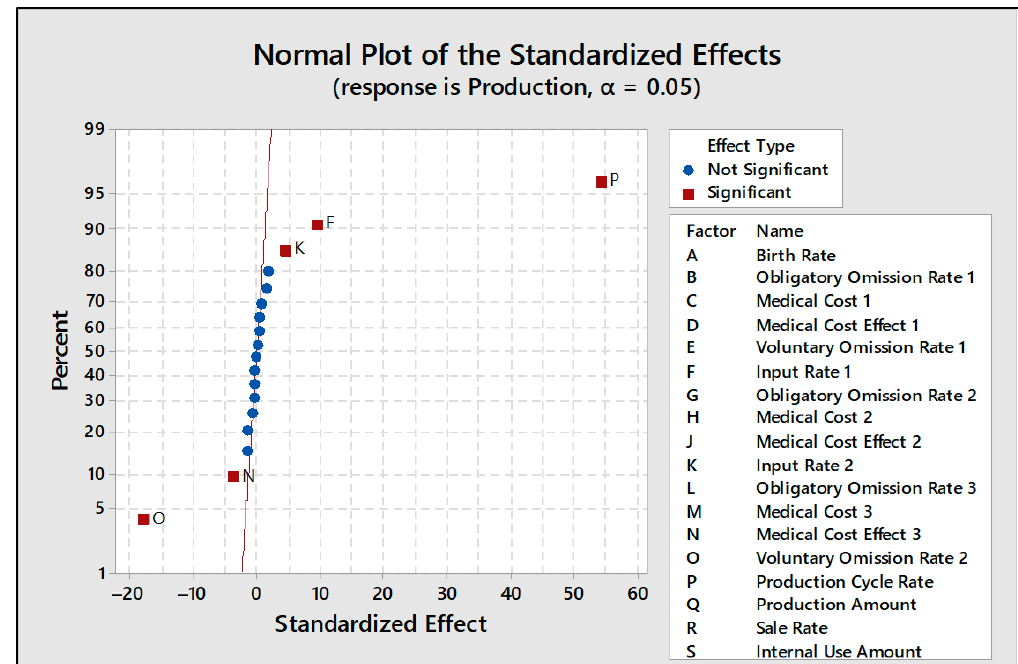
Figure 6. Pareto chart for the identification of important variables in production.